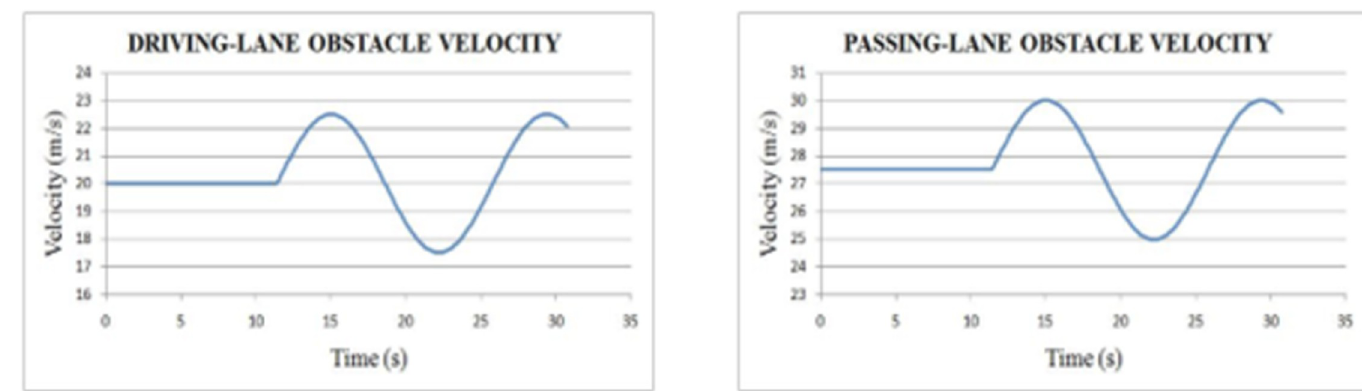
Fig 12. Driving lane and passing lane obstacle velocities.